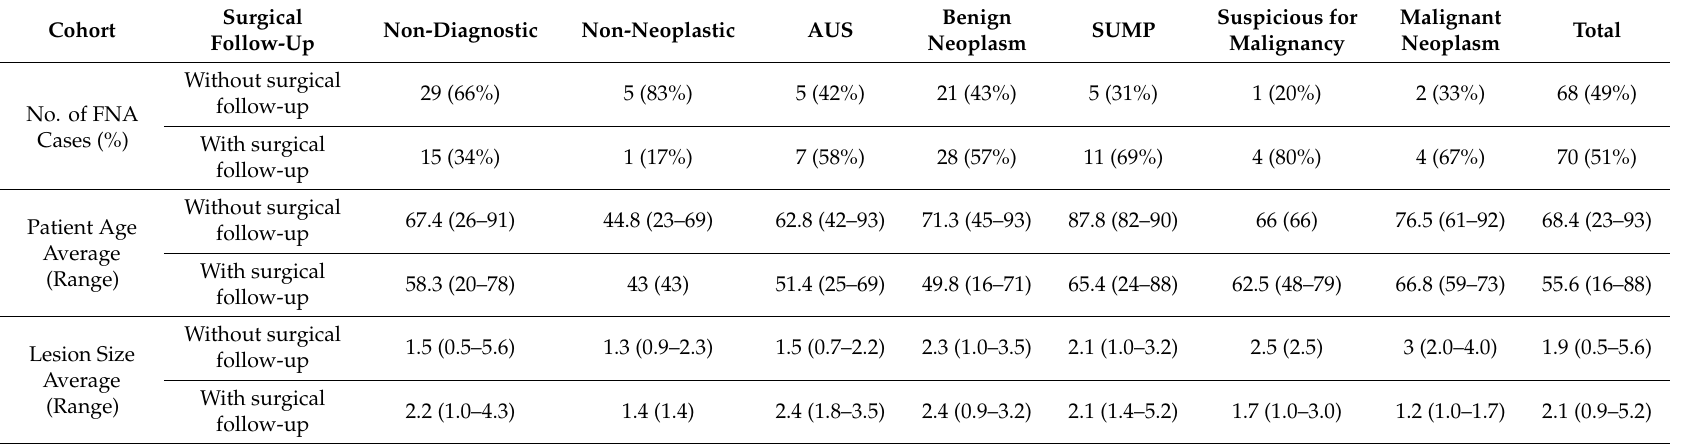
Table 1. Milan System for Reporting Salivary Gland Cytopathology (MSRSGC): Clinical Characteristics, Patient